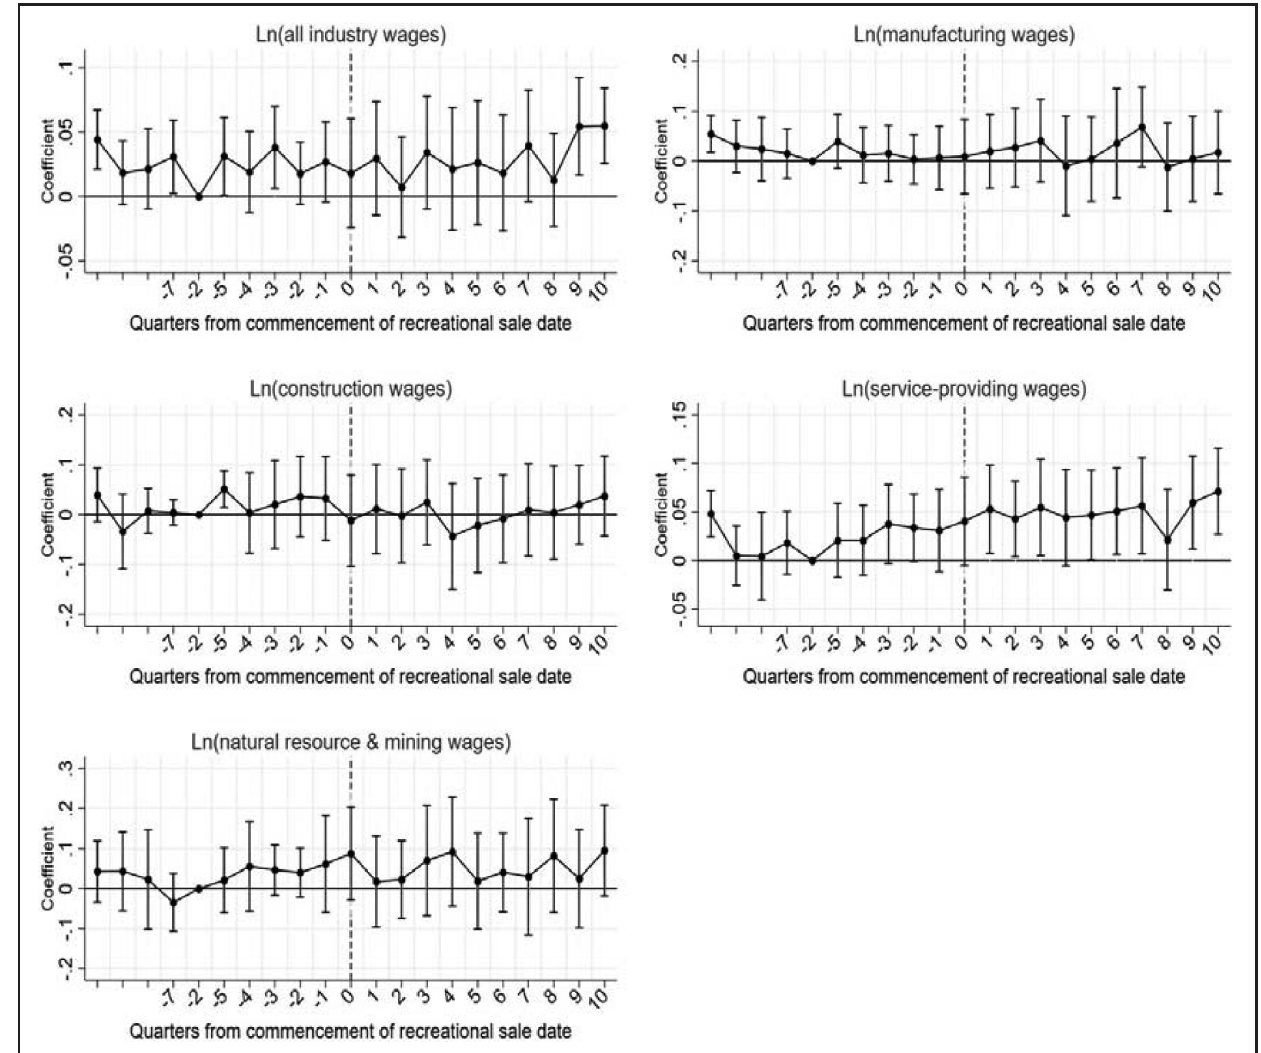
Figure A8 Effect of recreational cannabis entry on Ln(wage) by industry – event